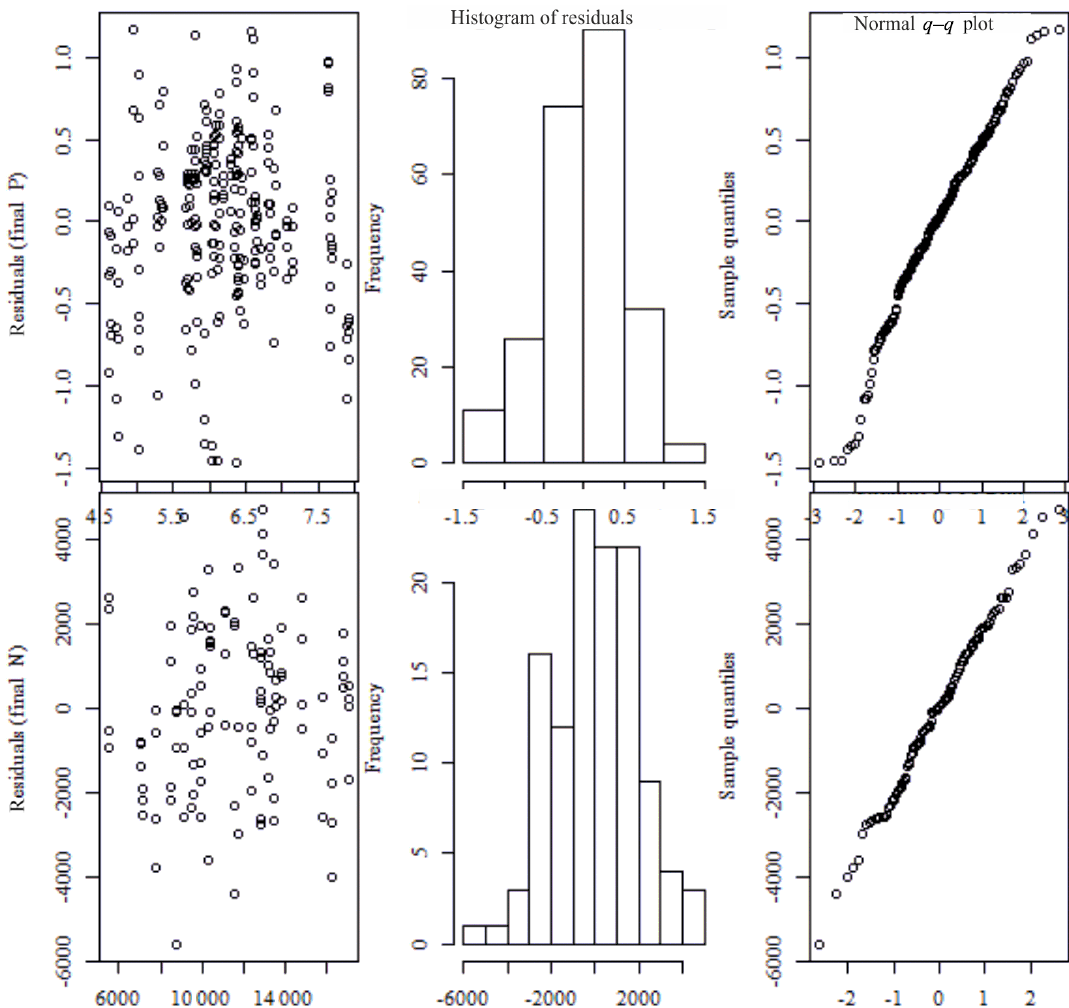
Figure C1. The fitted values vs. residuals: q – q plots and histograms of residuals from the mixed-effect models (the upper row shows val- ues for phosphorus, and the lower row shows values for